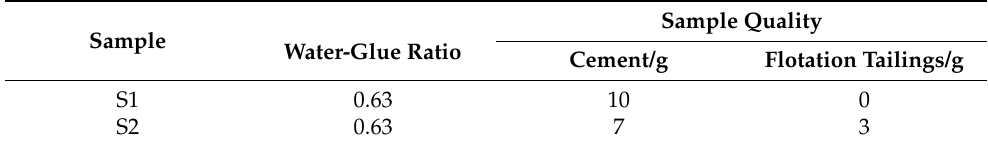
Table 3. Table 3. Specimen hydration exotherm test protocol.